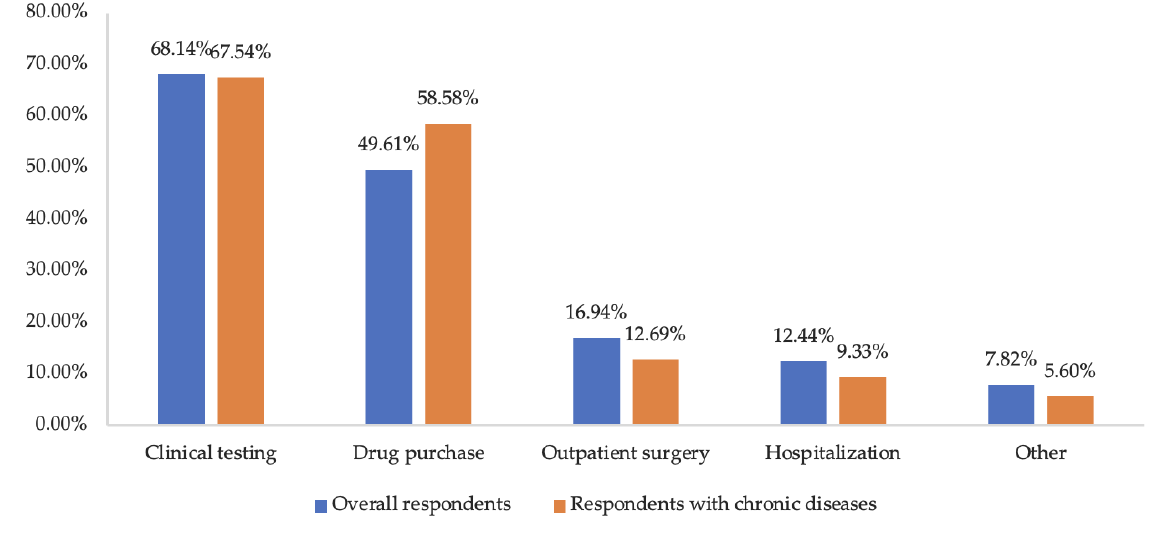
Figure 1. Types of health services affected during January to February 2020. After logistic regression analysis (Table 2), education level of middle high